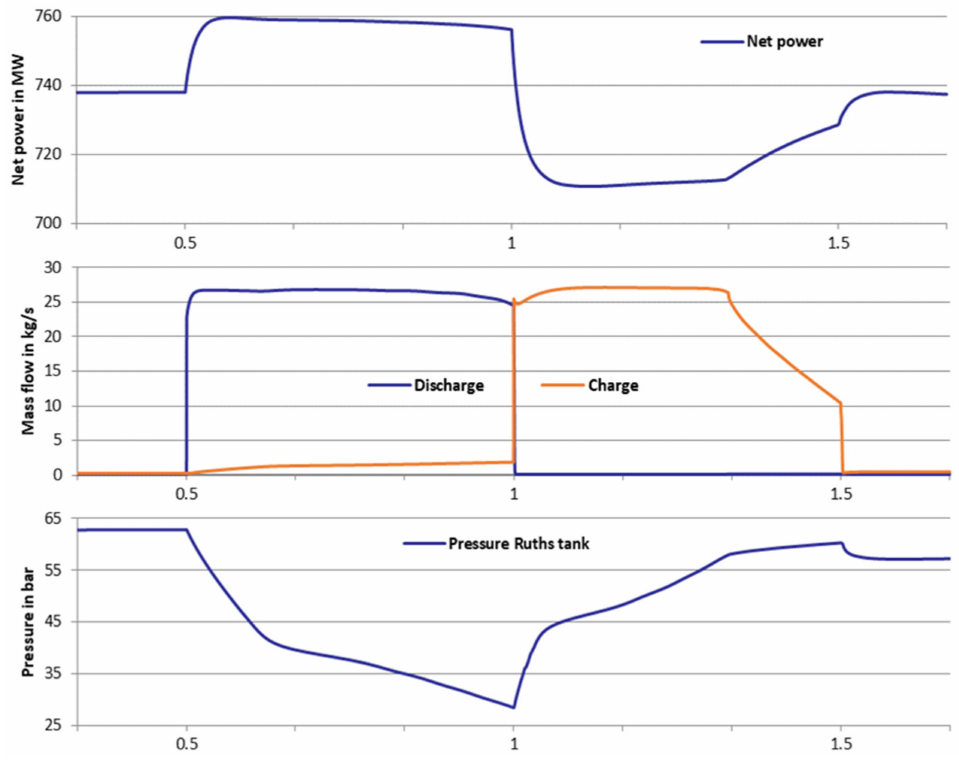
Figure 7. Characteristics of the essential parameters during the discharging and charging process (CRH/LS-HPPH7_directly